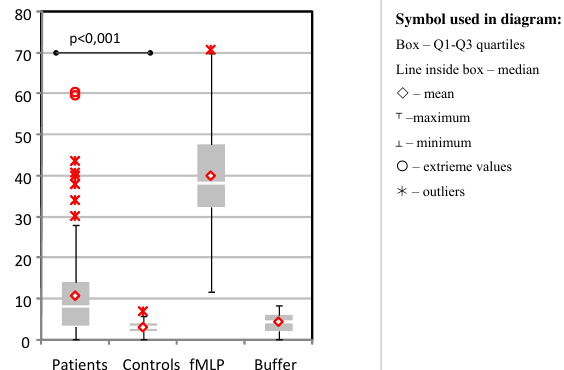
Symbol used in diagram: Box – Q1-Q3 quartiles Line inside box – median  – mean